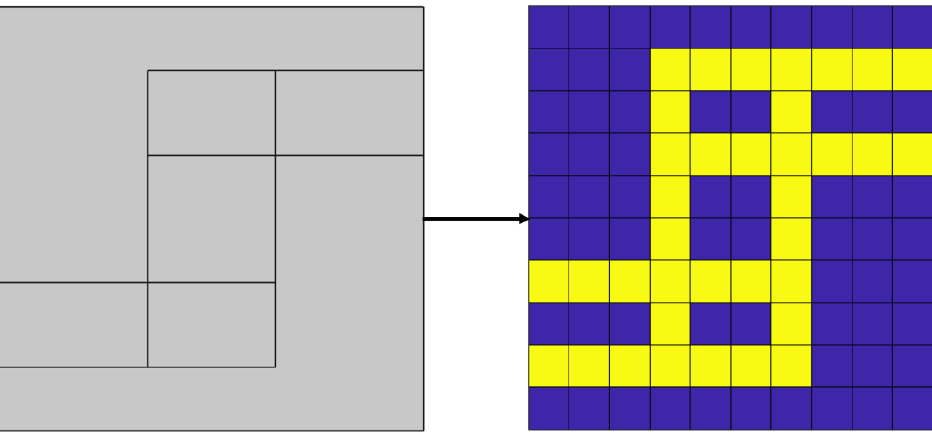
Figure 3. Schematic diagram of high permeability grid mapping from the fracture network.